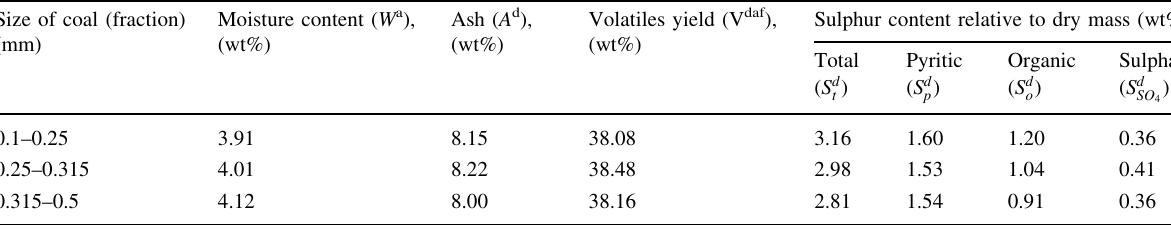
Table 6 Characteristics of initial materials Size of coal (fraction)